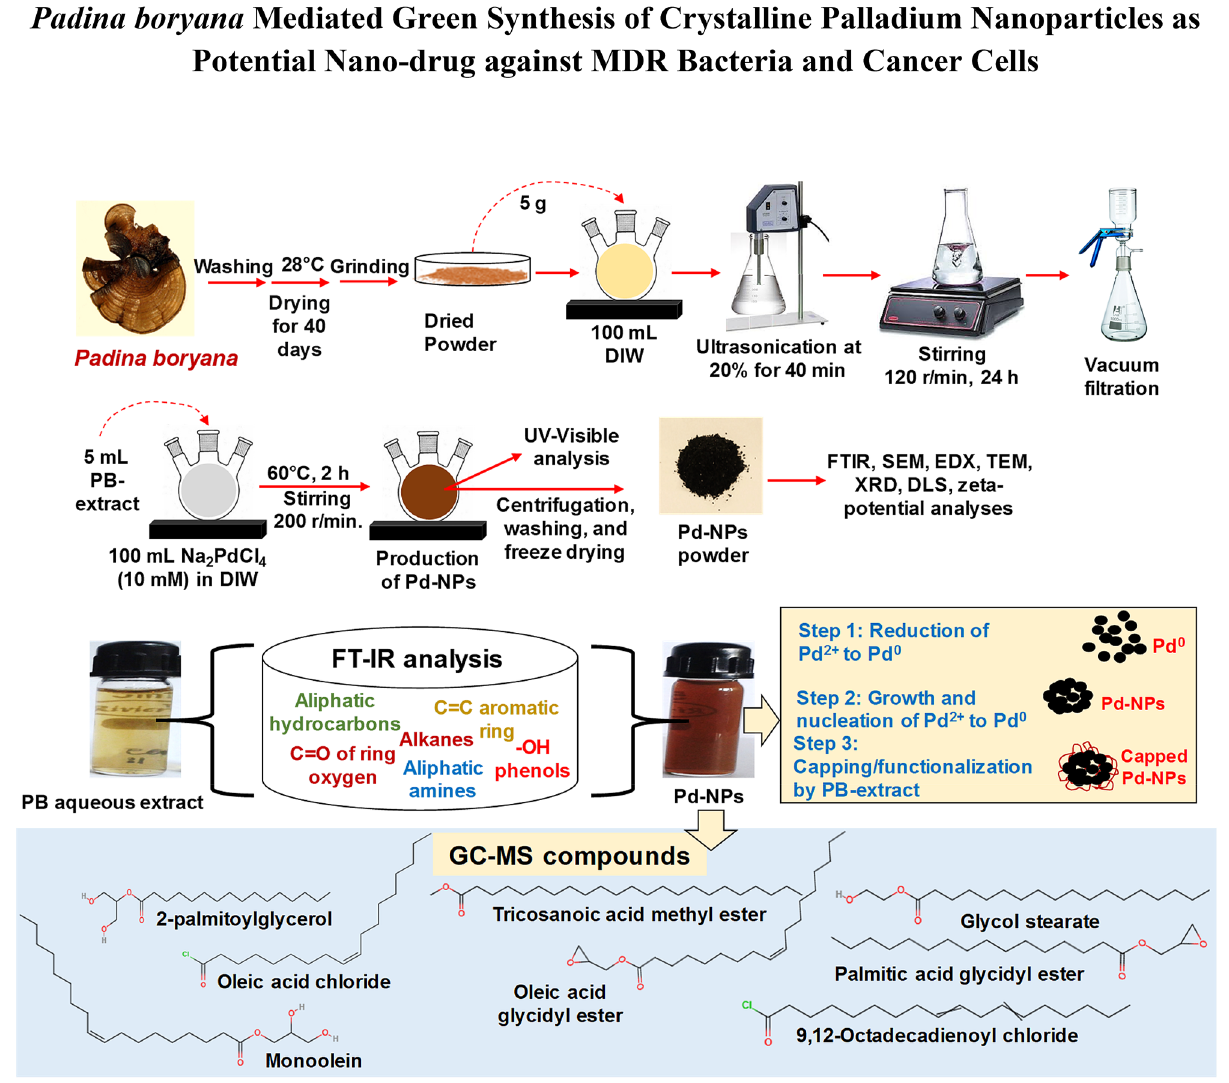
Figure 1. Scheme for P. boryana extract preparation, Pd-NPs fabrication, their characterization, and determination of capping by various